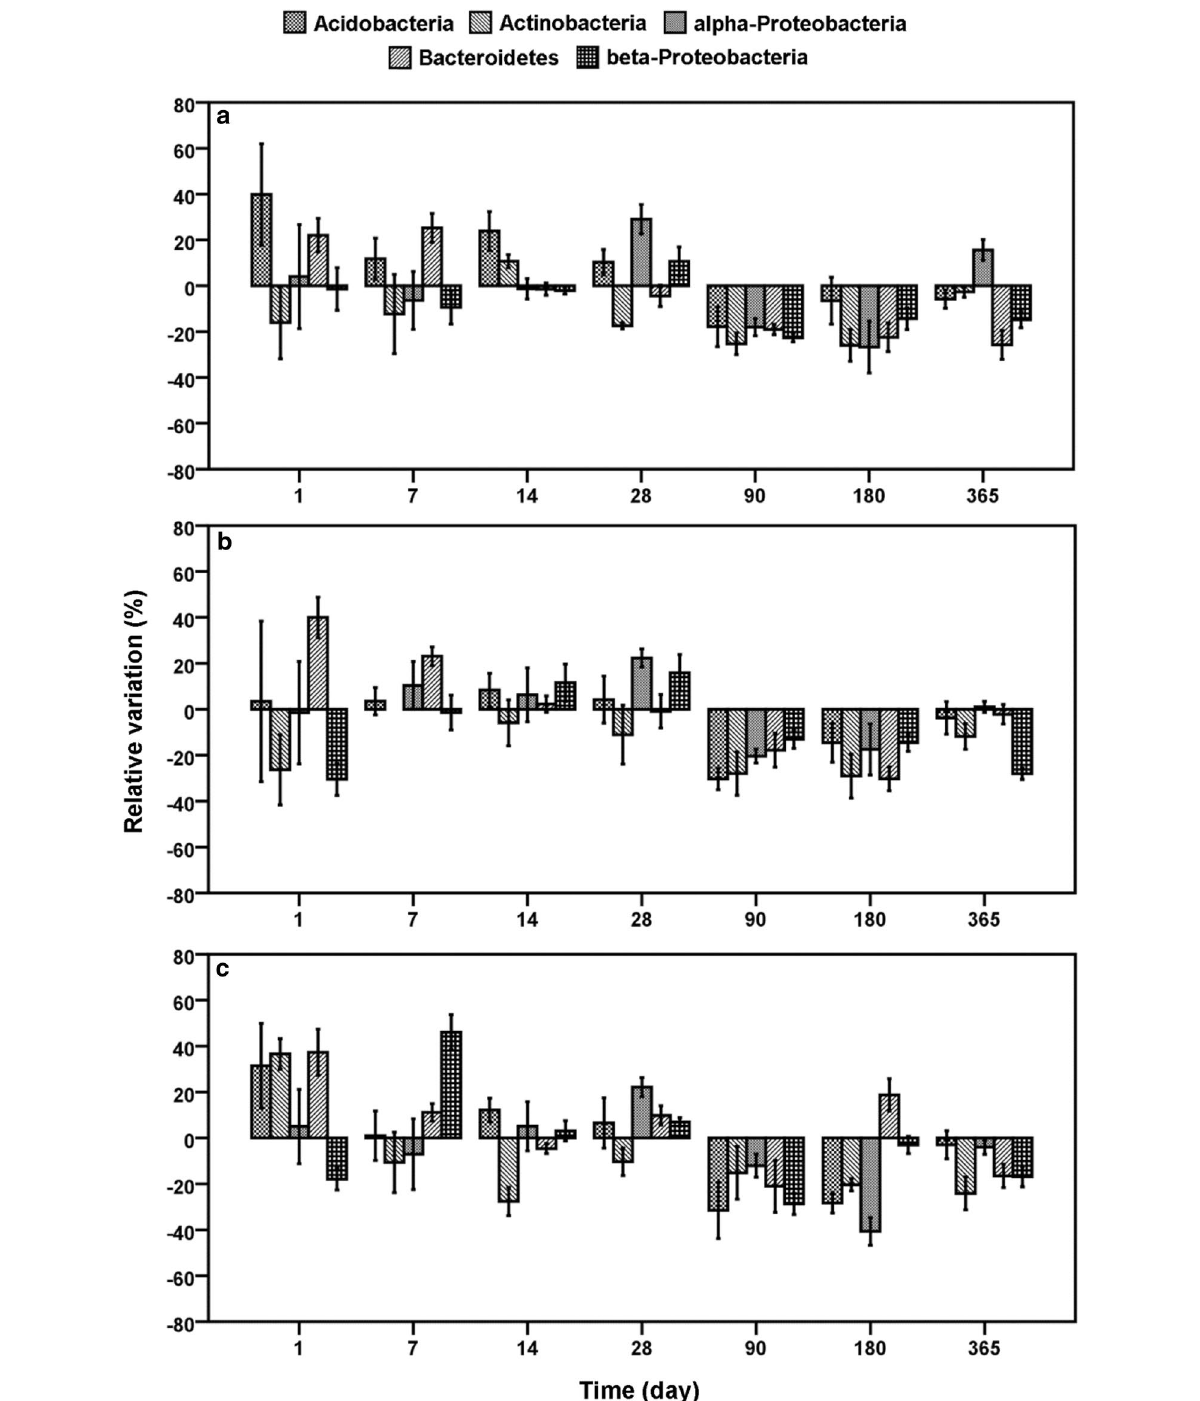
Fig. 2 Relative variations of Acidobacteria , Actinobacteria , alpha ‑ Proteobacteria , Bacteroidetes and beta ‑ Proteobacteria compared to untreated control related to time at different Ag + concentrations. a 0.01 mg Ag + kg − 1 , b 0.10 mg Ag + kg − 1 , c 1.00 mg Ag + kg −